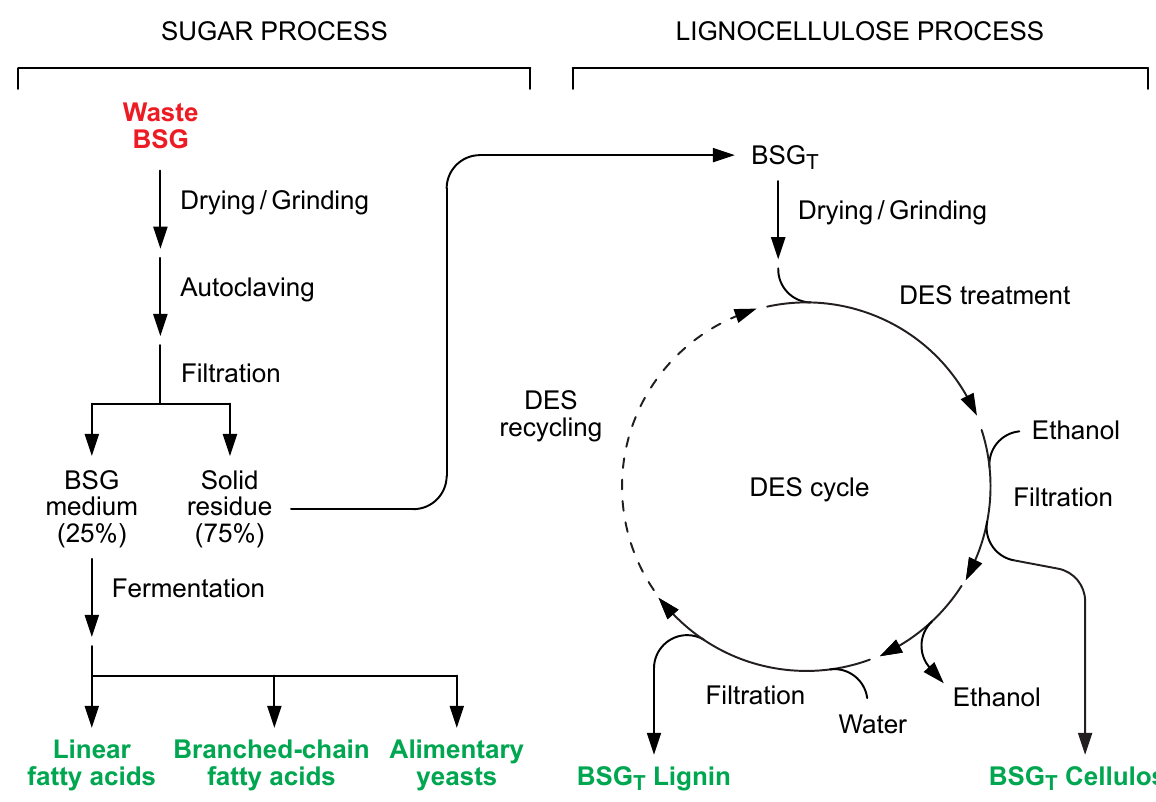
Figure 2. Integrated process for complete BSG waste valorization, subdivided into a sugar process and a lignocellulose process. In the first one, BSG waste is autoclaved and then separated into a sugar-rich medium and a solid residue. Different bioderivatives can be obtained from the former by fermentation. The solid lignocellulosic residue (BSG T ) is instead fractionated with DES to obtain purified lignin and cellulose. The DES is then recovered and recycled in a closed-loop